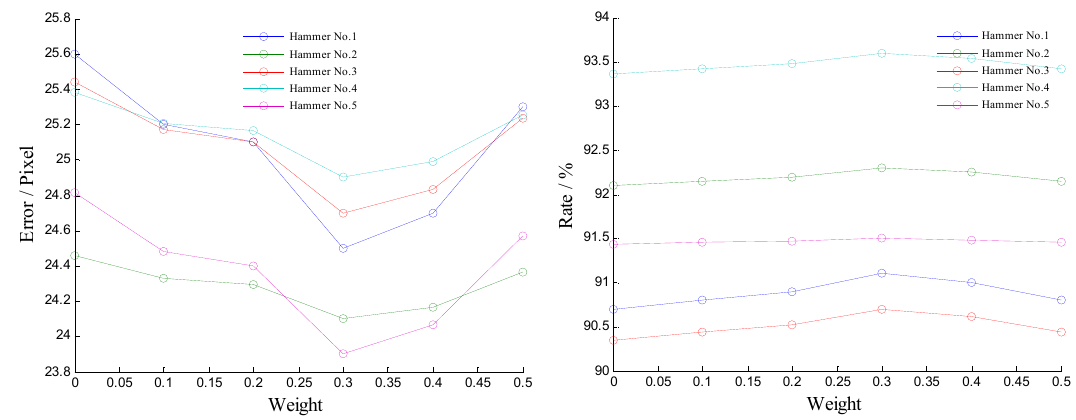
Figure 10. Comparison of two indexes under different weight.